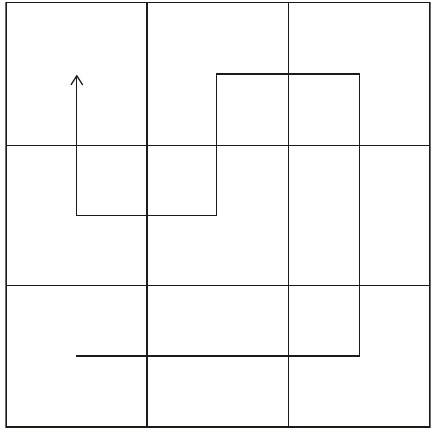
Figure 2: Filling curve path 2.